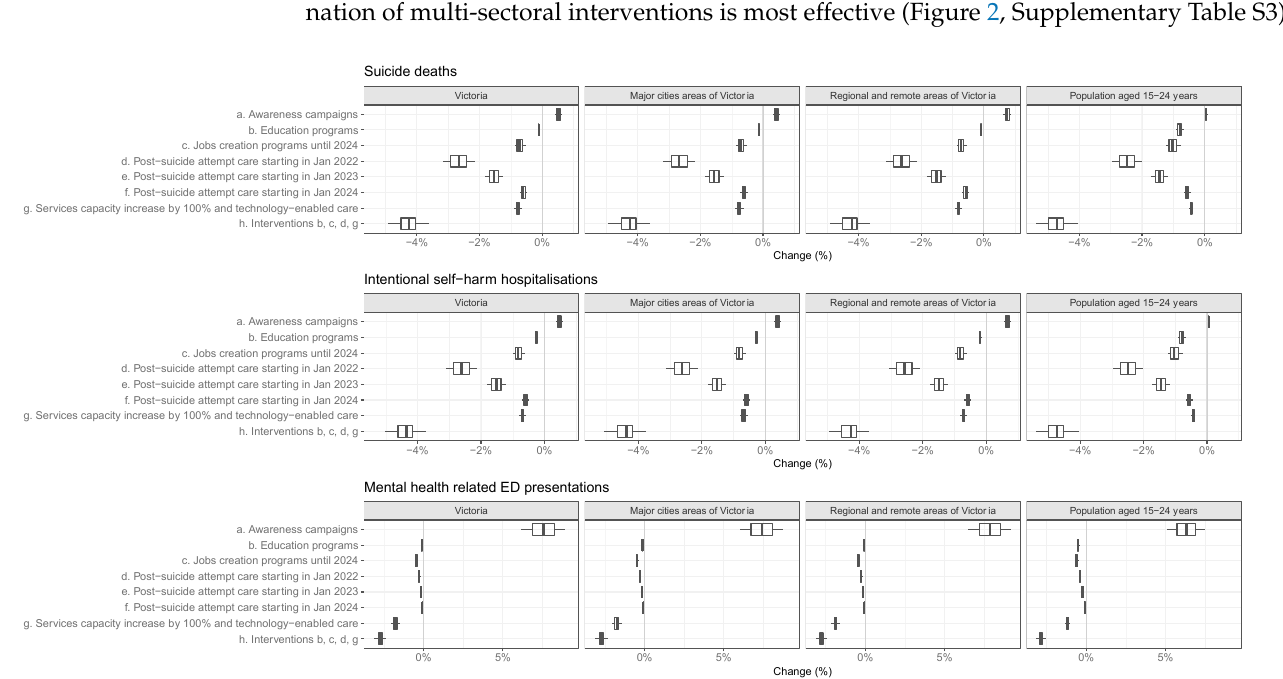
Figure 2. The impact of interventions: a percentage change in projected cumulative adverse mental health outcomes between March 2020 and March 2026, with several interventions compared to the COVID-19 baseline derived from the sensitivity analysis. Note that the horizontal axes are drawn at different scales for the three outcomes to improve legibility.